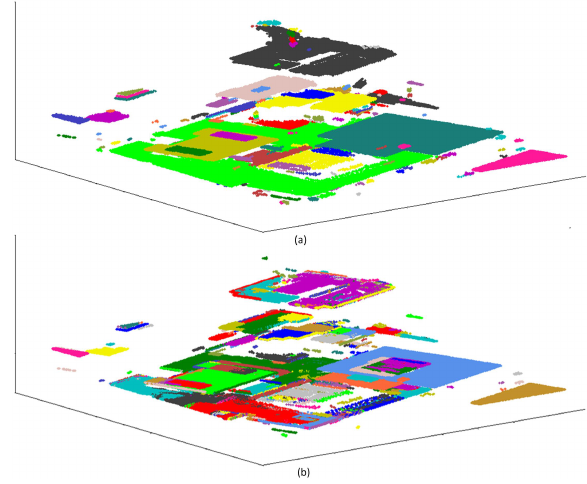
Figure 5: (a) Clusters of points for the sample scene in Figure 3 and (b) extracted planar